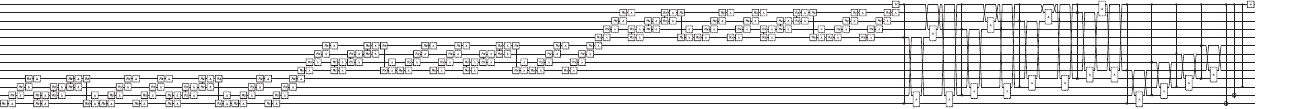
FIG. 12. Circuit that we simulate in Fig. 3. A controlled- SWAP gate acting on qubits k , l , and m is followed by 2-qubit depolarizations between qubits k , l and k , m and l , m . Avariant in which damping errors follow the depolarizations effectively resulted in the same error mitigation